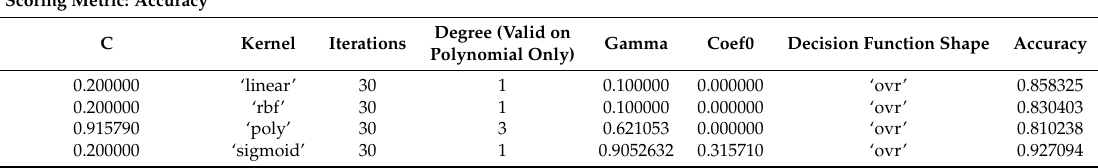
Table 3. SVM Parameters obtained using accuracy as the scoring metric (previously processed with dual-class